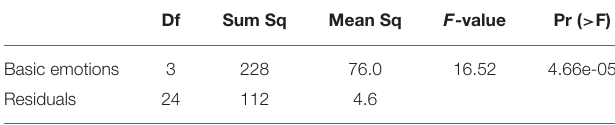
TABLE 4 | ANOVA analysis results provided by the four candidates.